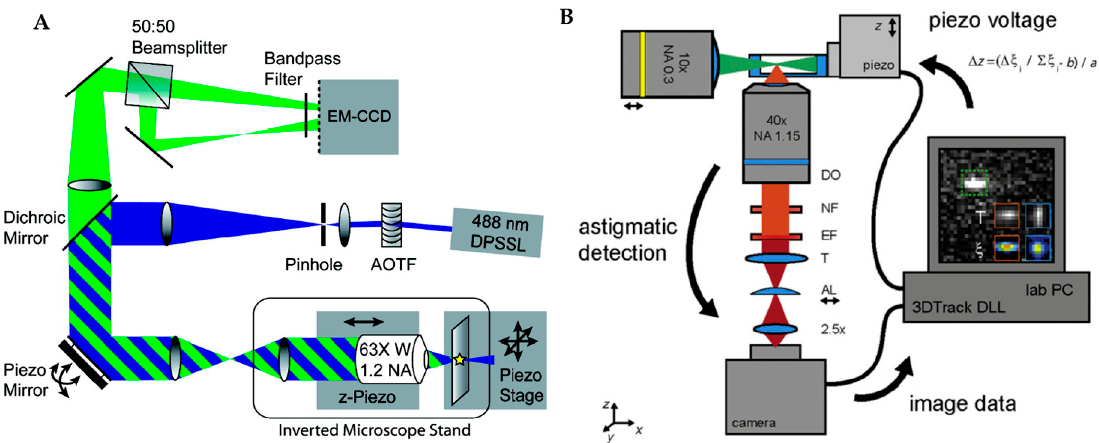
Figure 11. ( A ) Schematic of image-based biplane active feedback 3D tracking. One part of fluorescence is transmitted through a 50:50 beamsplitter and imaged onto the EMCCD camera while the other part of fluorescence is reflected by beamsplitter and imaged on a di ff erent side of the EMCCD. The reflected fluorescence has a longer path so that two axial planes can be monitored synchronously. The piezo mirror and Z piezo stage are used to move the laser focus in 3D. Adapted from reference